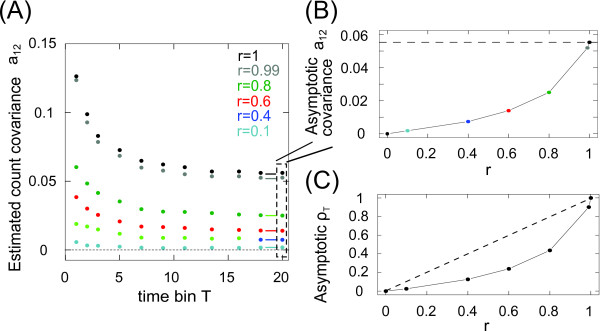
Finite asymptotic limit of covariancesaijand correlation coefficientρT. a Count covariance a12=∑q=1∞σX1,X22(q) vs. time bin T for varying correlation strengths r in the case of two identical neurons. The covariances converge for increasing time bin T towards the value predicted in Theorem 4.1 (indicated by small, thick lines). Here τs=1, and ψ=0.3. b Limit value of the covariance a12 vs. r for T=20τs (from a) vs. r. The case of r=1 (black) corresponds to the variance a11≈5.5⋅10−3, indicated by the dashed horizontal line. c Correlation coefficient ρT vs. r for large time bins (T=20τs). The dashed line indicates the equality line